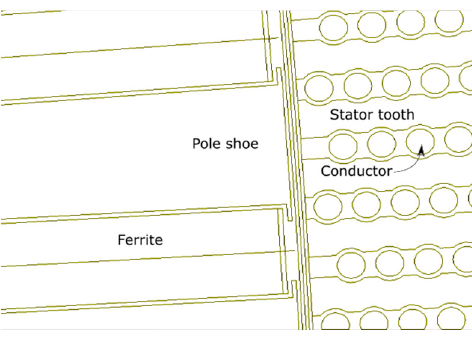
Figure 4. The geometry in the software Ace, showing a close view of a 2D segment of the LG with a translator including ferrite permanent magnets (PMs) and T-shaped pole shoes next to the stator.